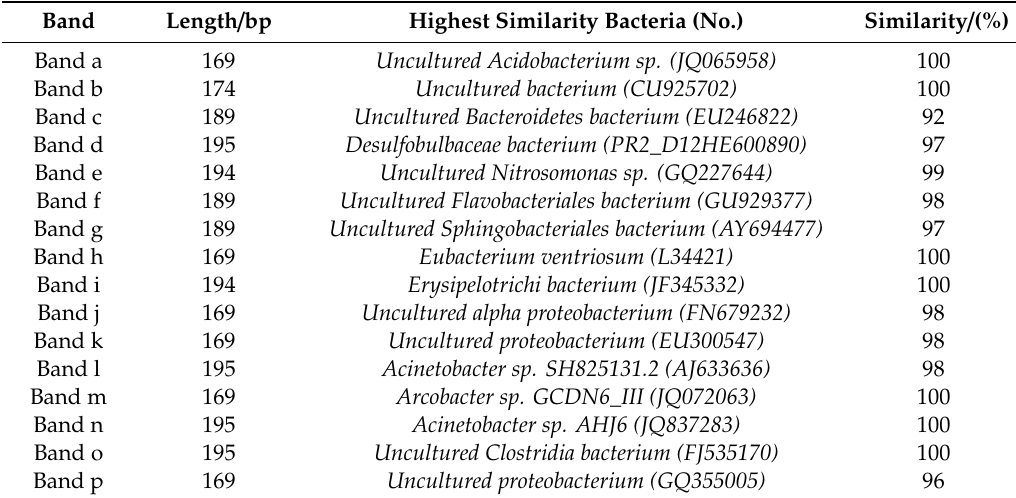
Table 3. 16SrDNA fragment sequencing analysis